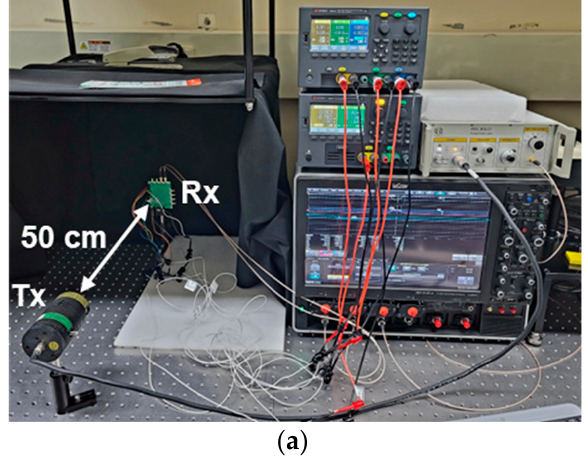
Figure 7. Measured frequency response of the proposed LiDAR AFE IC.